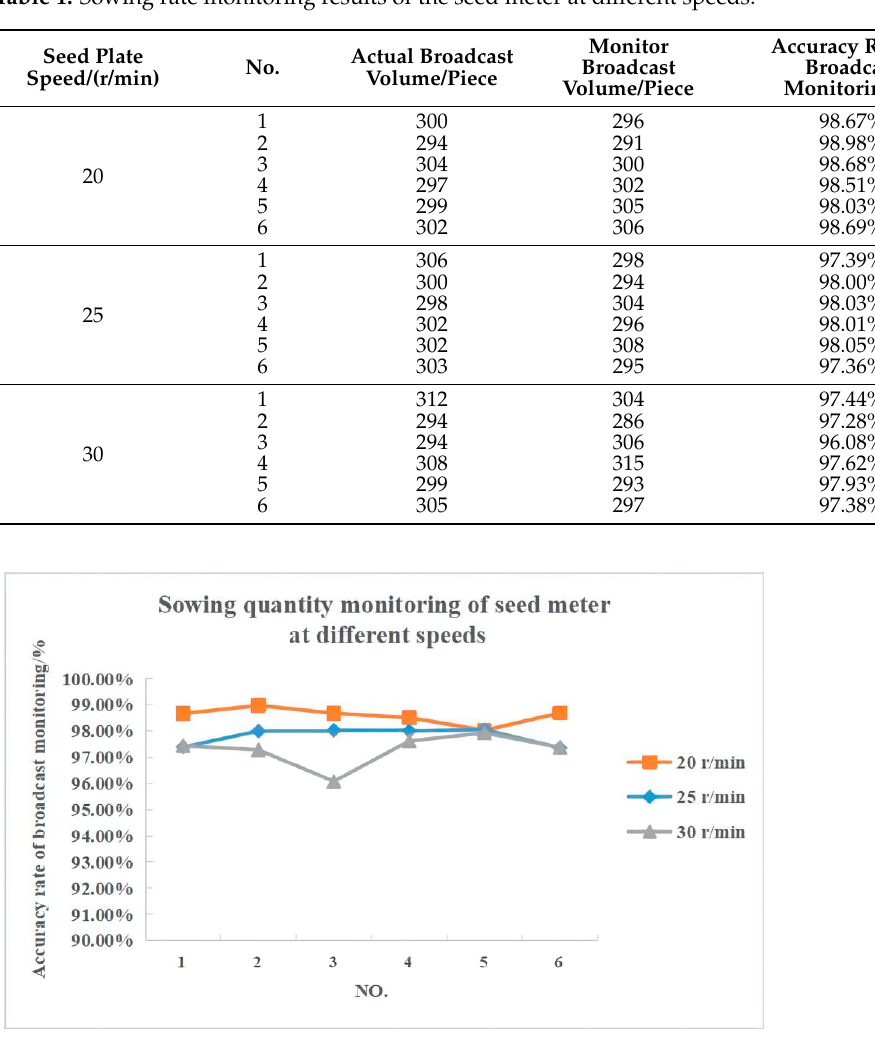
Table 1. Sowing rate monitoring results of the seed meter at different speeds.